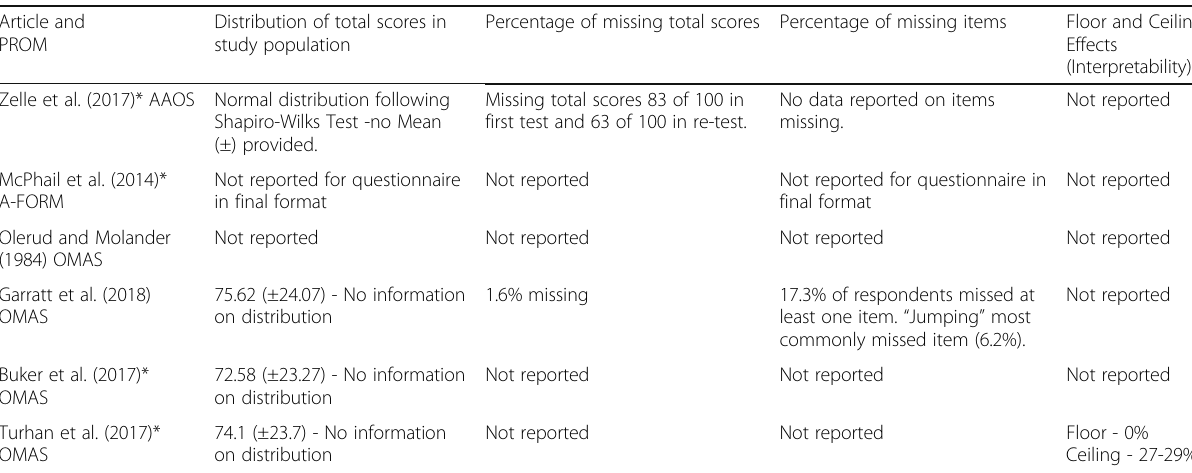
Table 7 Interpretability evidence of the PROMs Distribution of total scores in study